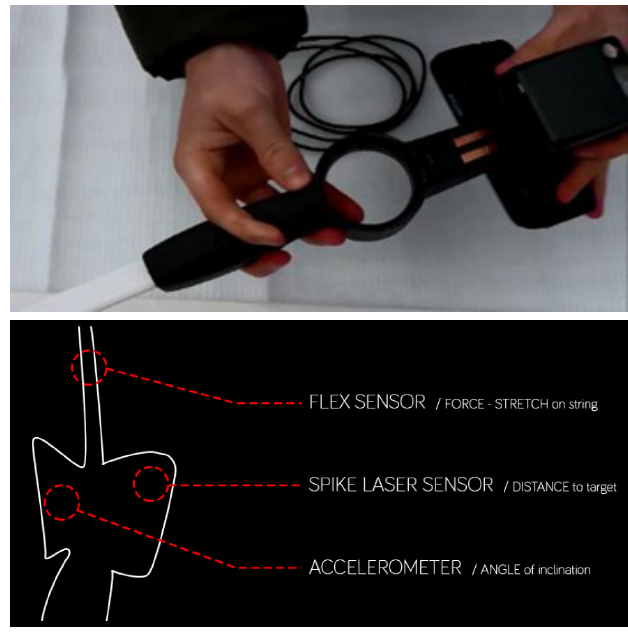
Figure 11. Disassemblable electrical connection and sensor placements of ArcAid bow.